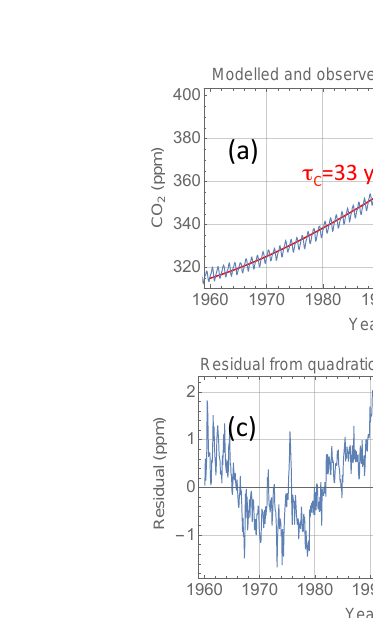
35ppm), and = 1 . 6. Panel (c) : ≈ 0 . 85, and the red, =